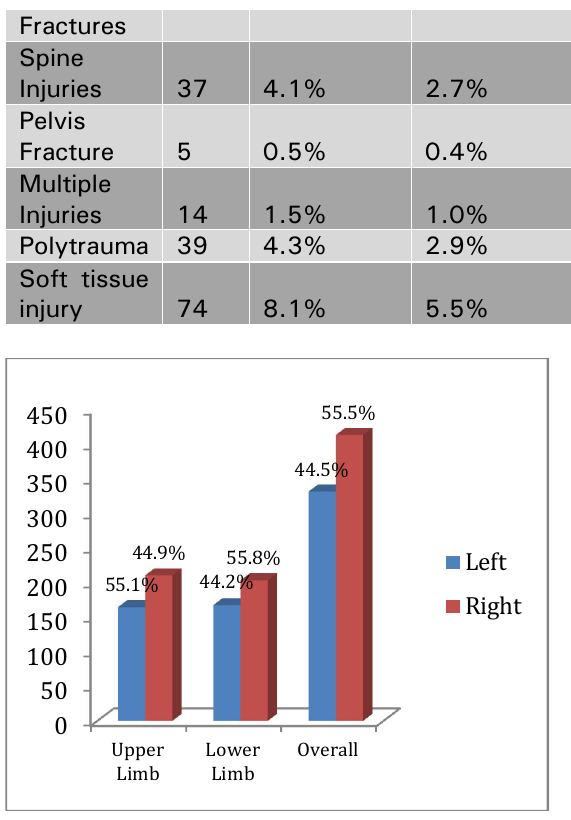
Figure3. Left side Vs Right Side Injuries Upper and lower limb fractures were also analyzed for Right or Left sided incidence. Right sided injury was dominant to left one in both Upper and Lower limb fractures with an overall ratio of 1.25:1 [Figure 3].